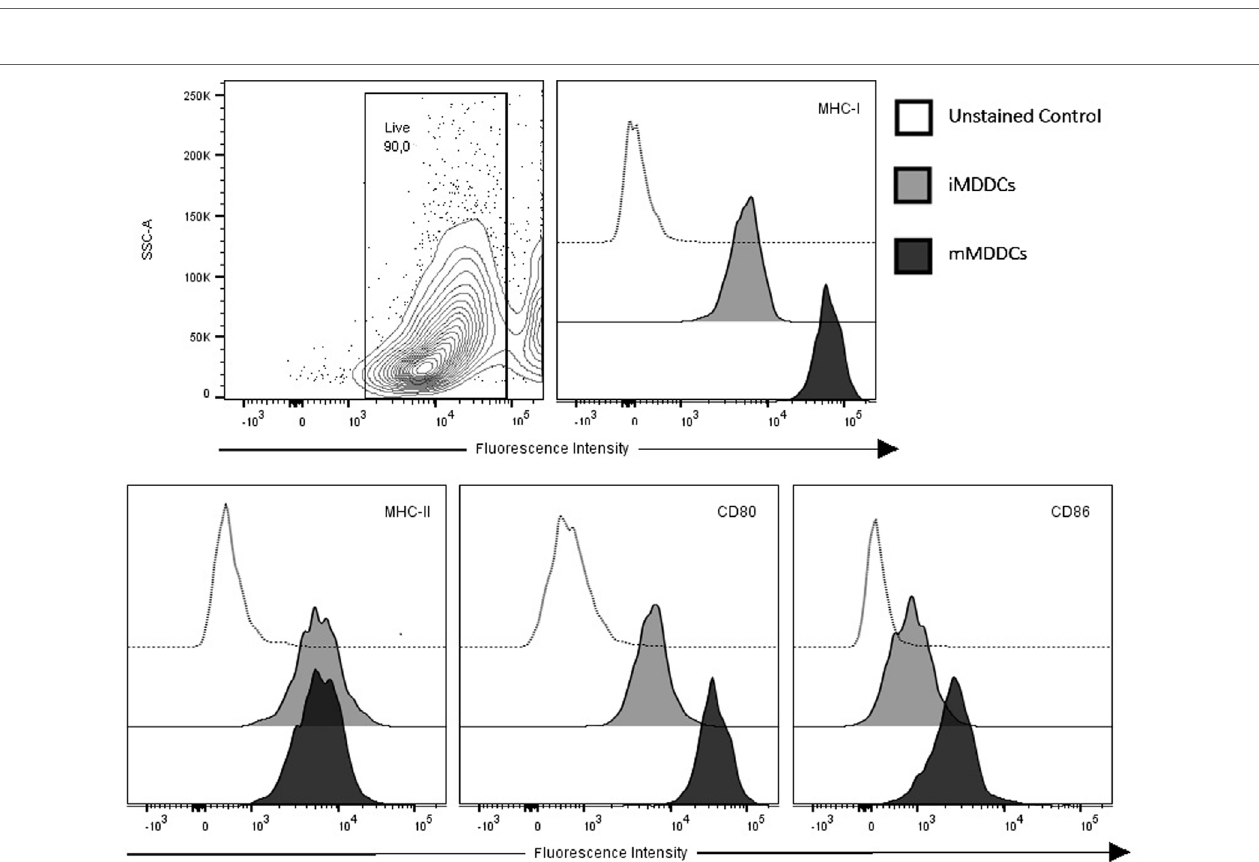
FigUre 5 | Monocyte-derived dendritic cells (MDDcs) upregulate surface expression of major histocompatibility complex (Mhc)-i, cD80, and cD86 during maturation . Contour plot of live cell population and flow cytometry analysis of surface expressions of MHC-I, MHC-II, CD80, and CD86 on immature MDDCs and mature MDDCs. Histograms of a representative animal are shown ( n =